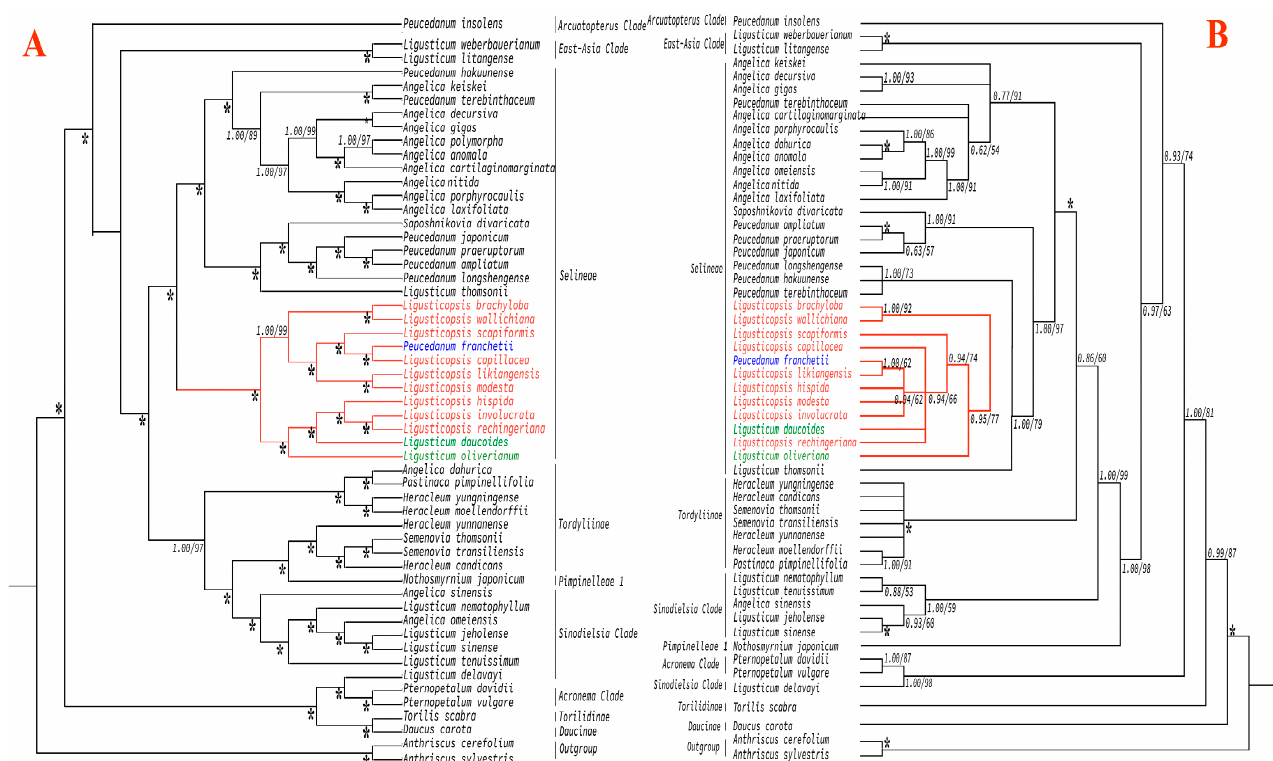
Figure 10. Phylogeny of the 54 taxa inferred from maximum likelihood (ML) and Bayesian inference (BI) analyses. Branch support was assessed using ML bootstrap percentage (BP) and Bayesian posterior probability (PP), and internal branches with less than 100 BP/1.0 PP were indicated with corresponding values. ( A ) Phylogenetic tree of 54 Apioideae taxa based on plastomes. ( B ) Phylogenetic tree of 54 Apioideae taxa based on ITS sequences. (* means the node with BS = 100 and PP = 1.00).